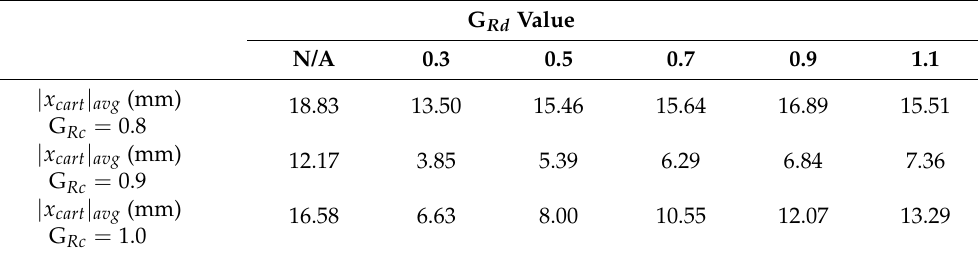
Table 3. Mean absolute values of outer-loop LQR d